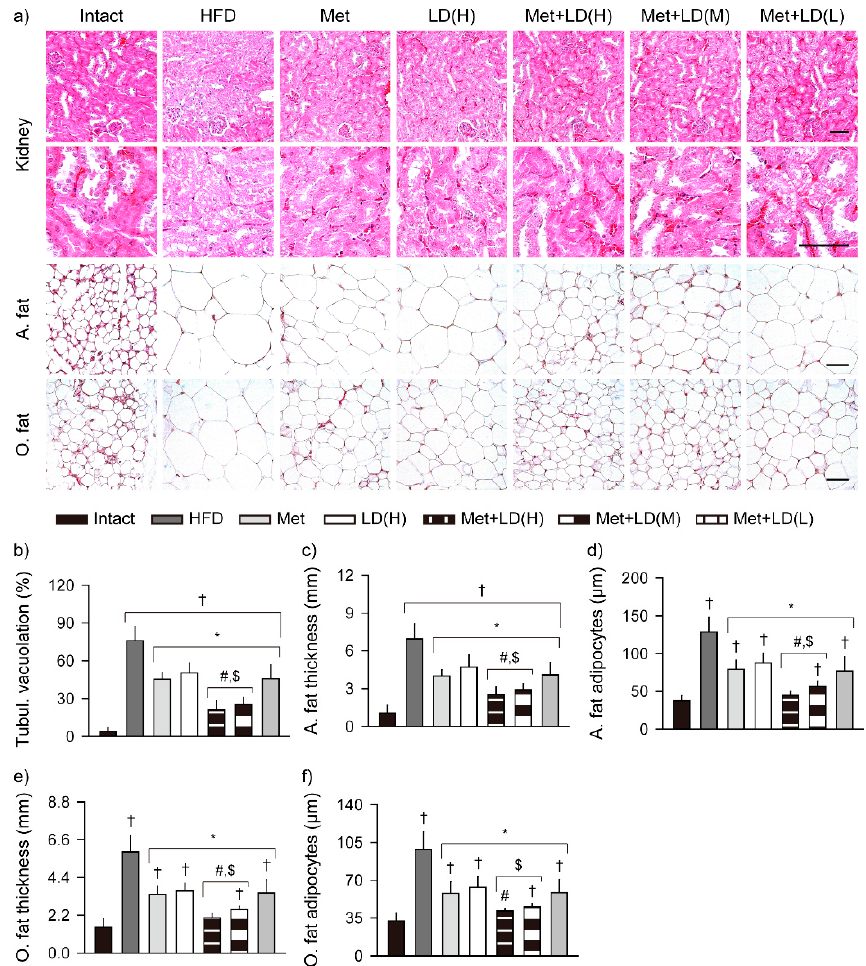
Figure 9. Histopathological improvements in lesions in the kidney and fat tissue. ( a ) Representative images of the kidney and abdominal (A.)/periovarian (O.) fat tissue in stains with hematoxylin and eosin. Each image was highly magnified (lower rows). Scale bars = 50 μ m. ( b ) Areas with renal tubular (Tubul.) vacuolation. ( c – f ) Thickness of the A./O. fat tissues and sizes of the adipocytes. Values are represented as the means ± SDs ( n = 8). †, *, #, and $: p < 0.05 vs. the Intact, HFD control (HFD), Met, and LD(H) groups, respectively.